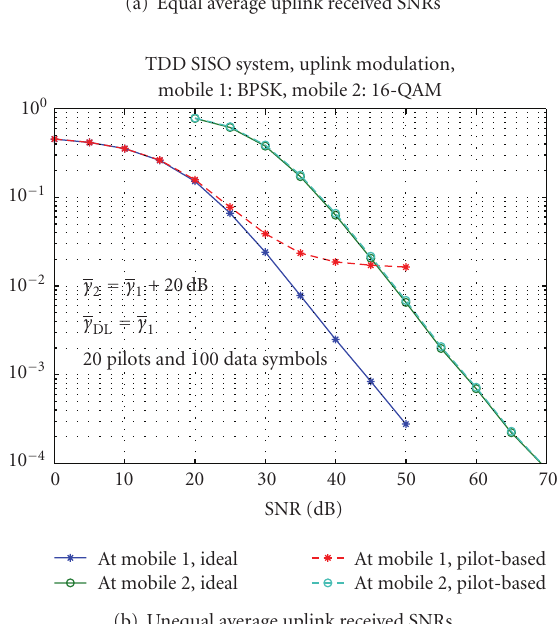
spanning over three consecutive OFDM symbols (which is a PUSC slot duration). The modulation symbols together with the pilot symbols needed to estimate the uplink channel are sent over 6 tiles distributed over frequency, where a tile is defined as four consecutive subcarriers over three consecutive OFDM symbols. Each tile contains 4 pilot symbols, placed at the corners of the tile, and 8 data symbols. An FEC block in WiMax comprises of a given number of slots and the maximum FEC block size is a function of the modulation order and channel coding rate. The WiMax standard supports 8 modulation order and coding rate combinations. These are QPSK modulation